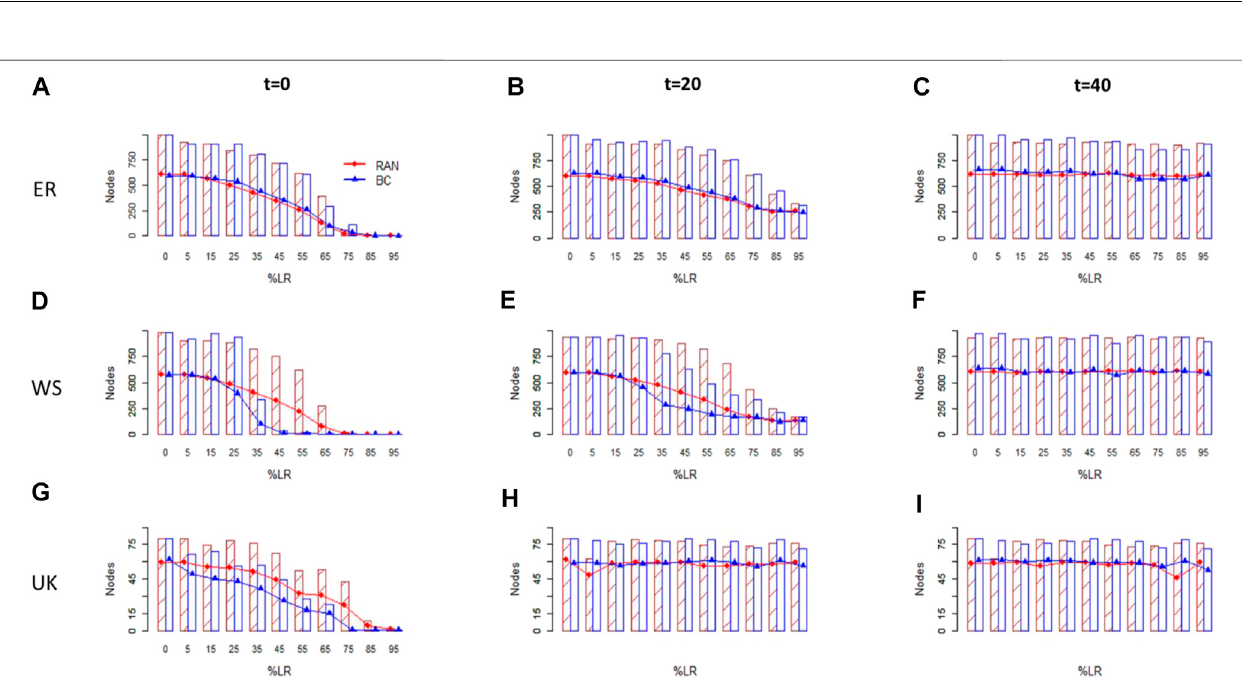
FIGURE2| Indicatorsofthedynamicepidemicspreadinginfectedpeak(Peak)andtotalinfected(TI)oftheSIRmodeloverthreenetworksanalyzedasafunctionof the fraction of the links removed (%LR). Bar plots indicate the TI; lines/points indicate the Peak. Red bar plots with diagonal lines indicate the spreading indicators of the network subjected to random link removal (RAN), whereas blue empty bar plots indicate the spreading indicators under link betweenness centrality removal (BC). Red/ circledescribesthespreadingindicatorsofthenetworksubjectedtorandomlinkremoval(RAN),whereasblue/triangleindicatesthespreadingindicatorsunderlink betweenness centrality removal (BC). The SIR model has per-day transmission probability β (cid:1) 0.04 and per-day recovery probability γ (cid:1) 0.06. The outcomes are the average of 10 3 simulations. 1th row : Panels (A – C) spreading indicators as a function of %LR over the ER N (cid:1) 1,000, p (cid:1) 0.008 model network; 2nd row : Panels (D – F) spreading indicators as a function of %LR for the WS N (cid:1) 1,000, p (cid:1) 0.3 model network; and 3rd row : Panels (G – I) spreading indicators as a function of %LR for the United Kingdom faculty real-world social network. 1th column: Panels (A,D, and G) the social distancing represented by the LR is implemented at t (cid:1) 0; 2nd column: Panels (B,E, and H) the LR is implemented at t (cid:1) 20; 3rd column: Panels (C,F, and I) the LR is implemented at t (cid:1)